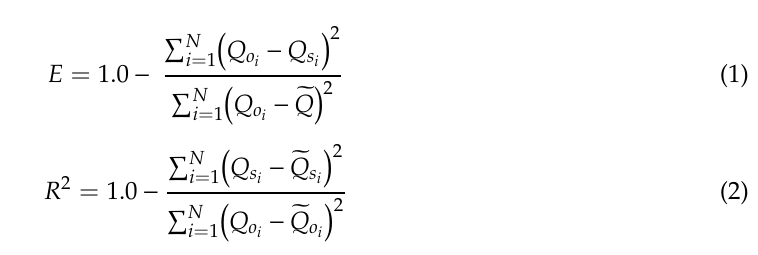
( b ) Figure 3. Variation in basin flow: ( a ) annual accumulated discharge in the Wami Ruvu basin; ( b ) annual flow reductions and affected riparian areas in Sub-Saharan Africa (selected basins). Water demand projections at all nodes showed remarkable increases in the water abstraction level at all abstraction points. The analysis found that the major demand nodes for the water utilized were domestic and irrigation consumption (see Table 2). Under the CT scenario, the total water demand in the WRB is projected to rise from 1050.0 million m 3 in the year 2015 to 2122.9 million m 3 in the year 2035, and under the DSM scenario the total water demand is projected to rise from 990.0 million m 3 in the year 2015 to 1715.8 million m 3 in the year 2035. Comparatively, under the DSM scenario, the average annual water demands are projected to decrease by 15% in each target year, from 1586.5 million m 3 in 2015 to 1352.9 million m 3 in 2035 (see Figure 4a and Table S3). Land use changes influenced by terrestrial water demand alter the hydrological cycle of a catchment by